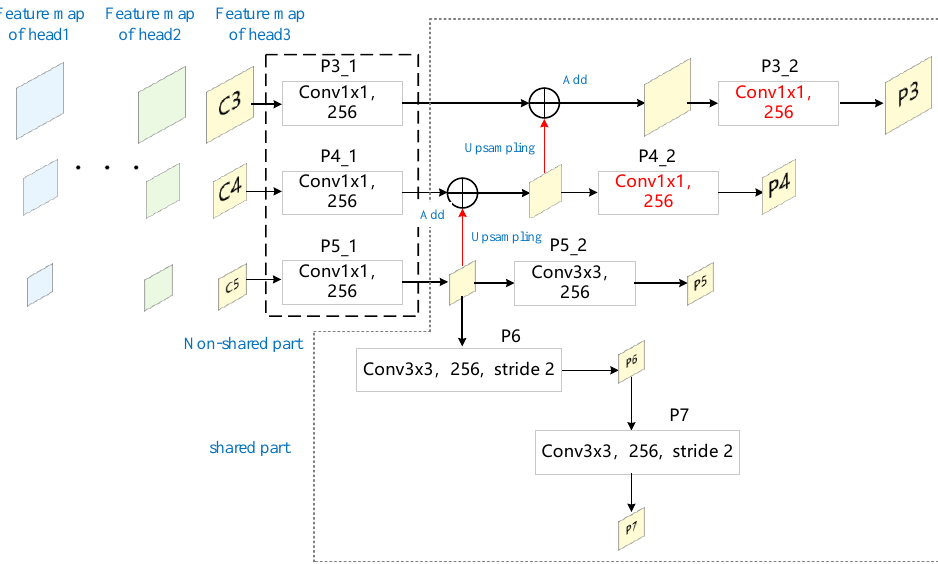
Figure 4. The structure of proposed lightweight shared feature pyramid